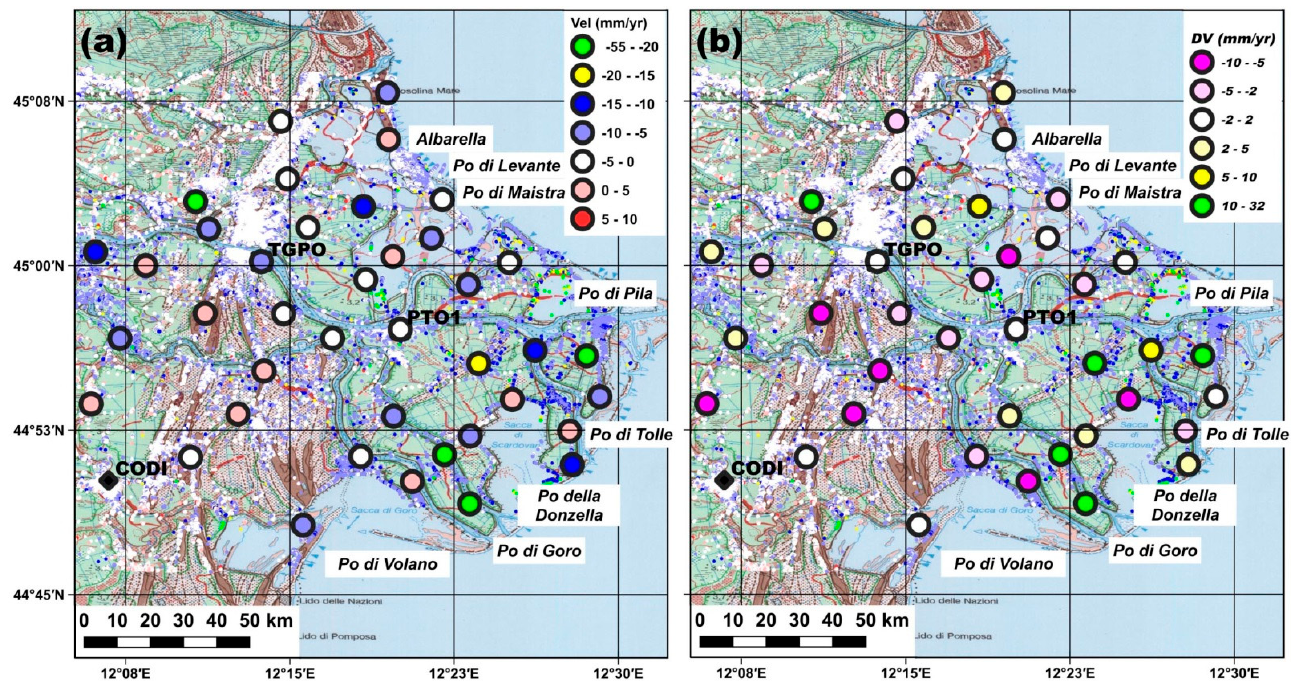
Figure 8. ( a ) Velocity map along the LOS obtained analyzing the Sentinel-1A/B observations acquired from 2014 to 2017. The color of the circles represents the LOS PODELNET GNSS velocities (Table 3) overlapped to the InSAR kinematic pattern using the same scale; ( b ) Differences between InSAR and GNSS velocities (Table 3) at the PODELNET sites (V InSAR − V GNSS ); are also shown the positions of the seven Po River terminal branches.